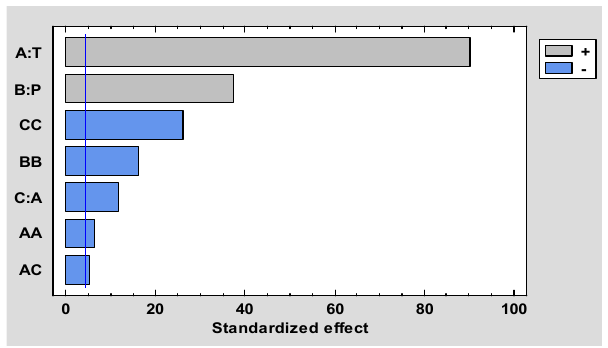
Figure 13. Effect of regression coefficients on moisture diffusion coefficient Deff.